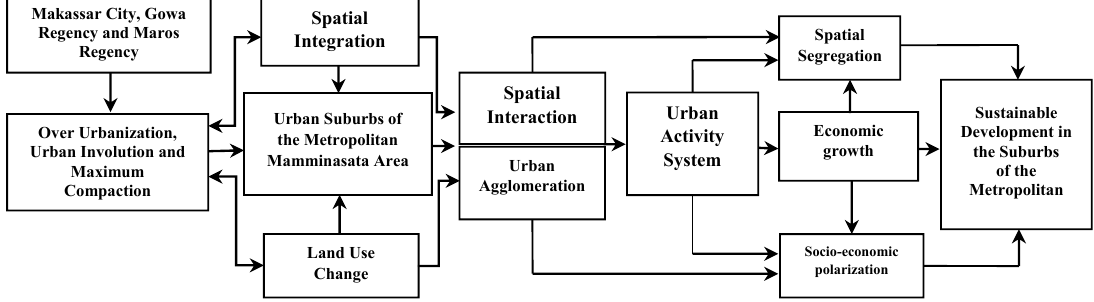
Figure 1. Conceptual Framework for Spatial Integration and Spatial Interaction in the Urban Suburbs of the Mamminasata Metropolitan Area. Source: author elaboration.